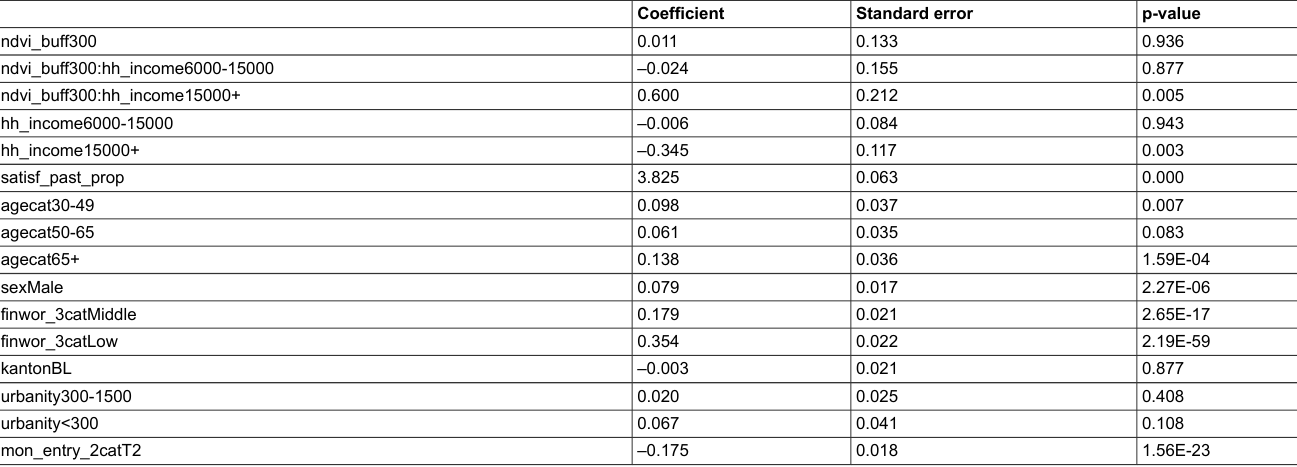
Figure 5: NDVI association with life satisfaction by financial wor- ries, adjusted for life satisfaction in the past, age categories, sex, household income, canton, degree of urbanisation, and month of entry.